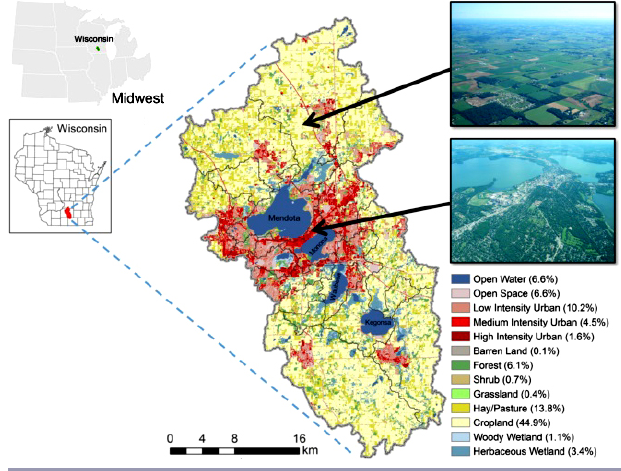
Fig. 2. Map of the Yahara River watershed (Wisconsin, USA) and the land-use/land-cover pattern (with percent cover) for 2011, derived from National Land Cover Data. Delineations of the Yahara watershed were based on light detection and ranging (LiDAR) elevation, sewer-sheds from the city of Madison, and a field-checked basin map from Dane County, Wisconsin. Two aerial photos in the upper-right corner were taken in summer 2013 and illustrate the typical agricultural landscape (top) and acceleration of urbanization (bottom) in this